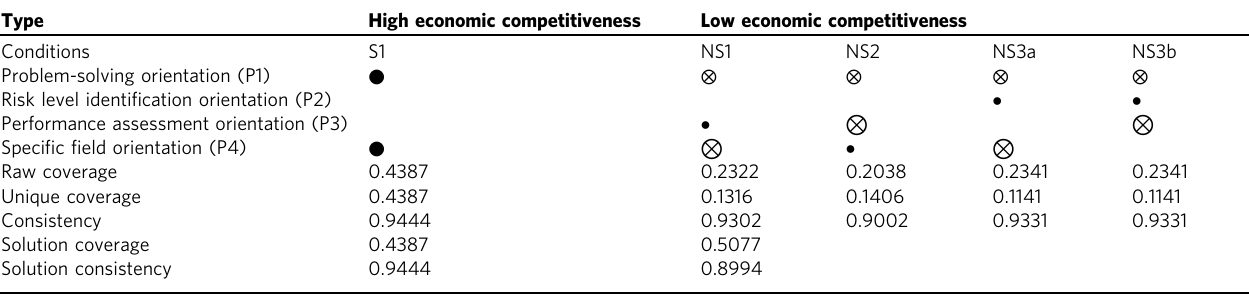
Table 2 High and low economic competitiveness con fi gurations in